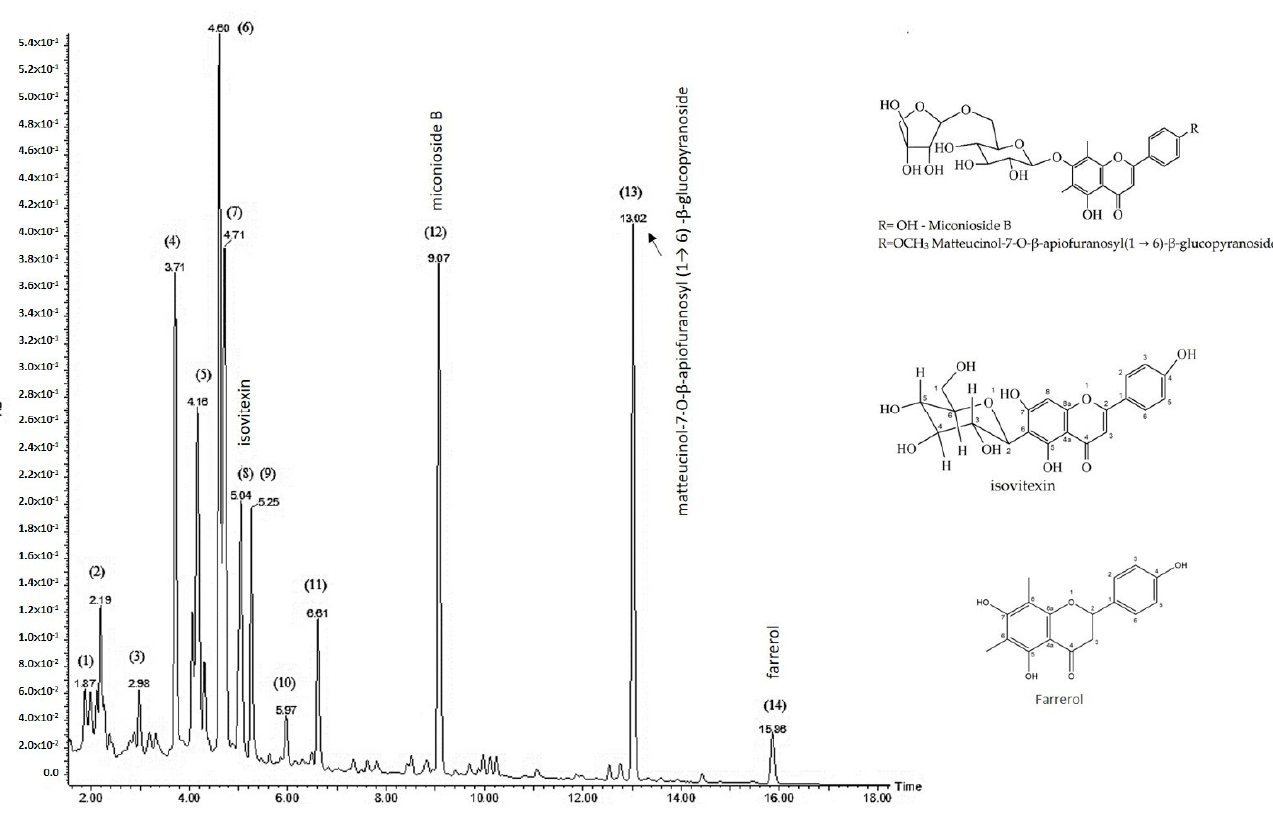
Figure 3. Chromatogram profile of M. chamissois Naudin aqueous extract from leaves (AEMC) analyzed UHPLC/UV/MS/MS at 354 nm. Detection at 354 nm, C18 column, flow rate of 0.3 mL/min, eluent: formic acid 1%, and acetonitrile in gradient system. The mass spectrometer was operated in several different modes for separate injections. The ion source temperature was 130 ◦ C, the desolvation gas was nitrogen at 950 L/h, the desolvation temperature was 450 ◦ C, and the capillary voltage was 2.7 KV. Table 2. Data from UHPLC/UV/MS/MS analysis of M. chamissois Naudin . aqueous leaf extract. Peak